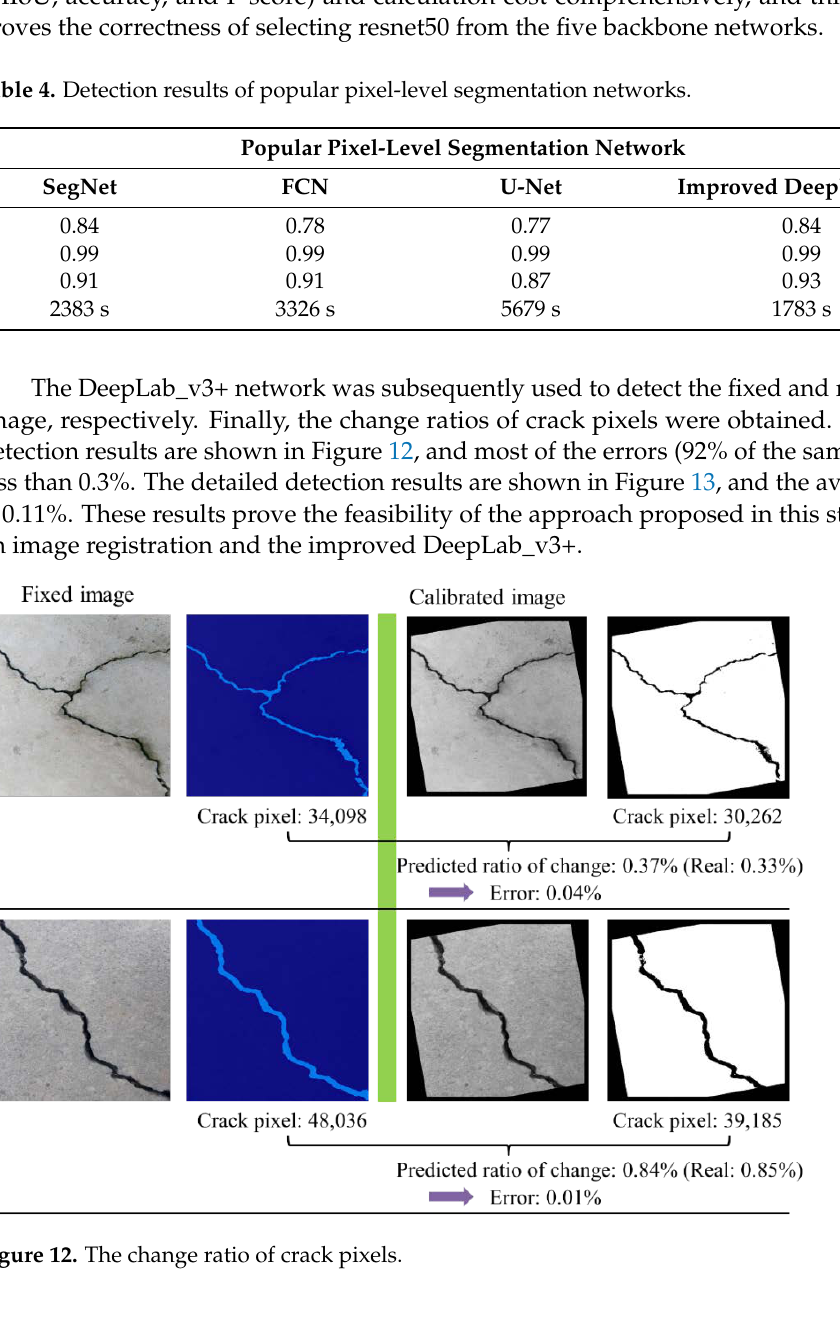
Figure 13. Errors of crack change ratio between the fixed image and calibrated images. 3.3. Analyses of Parameters The neural network adopts gradient descent algorithms to obtain the optimal weights (w) of the network, which brings the more accurate prediction results. The most used gradient descent algorithms included stochastic gradient descent with momentum (sgdm), root mean square propagation (rmsprop), and adaptive moment estimation (adam), and the details were described in the reference [35]. In order to explore the most suitable gradient descent algorithm for crack detection, the sgdm, rmsprop, and adam